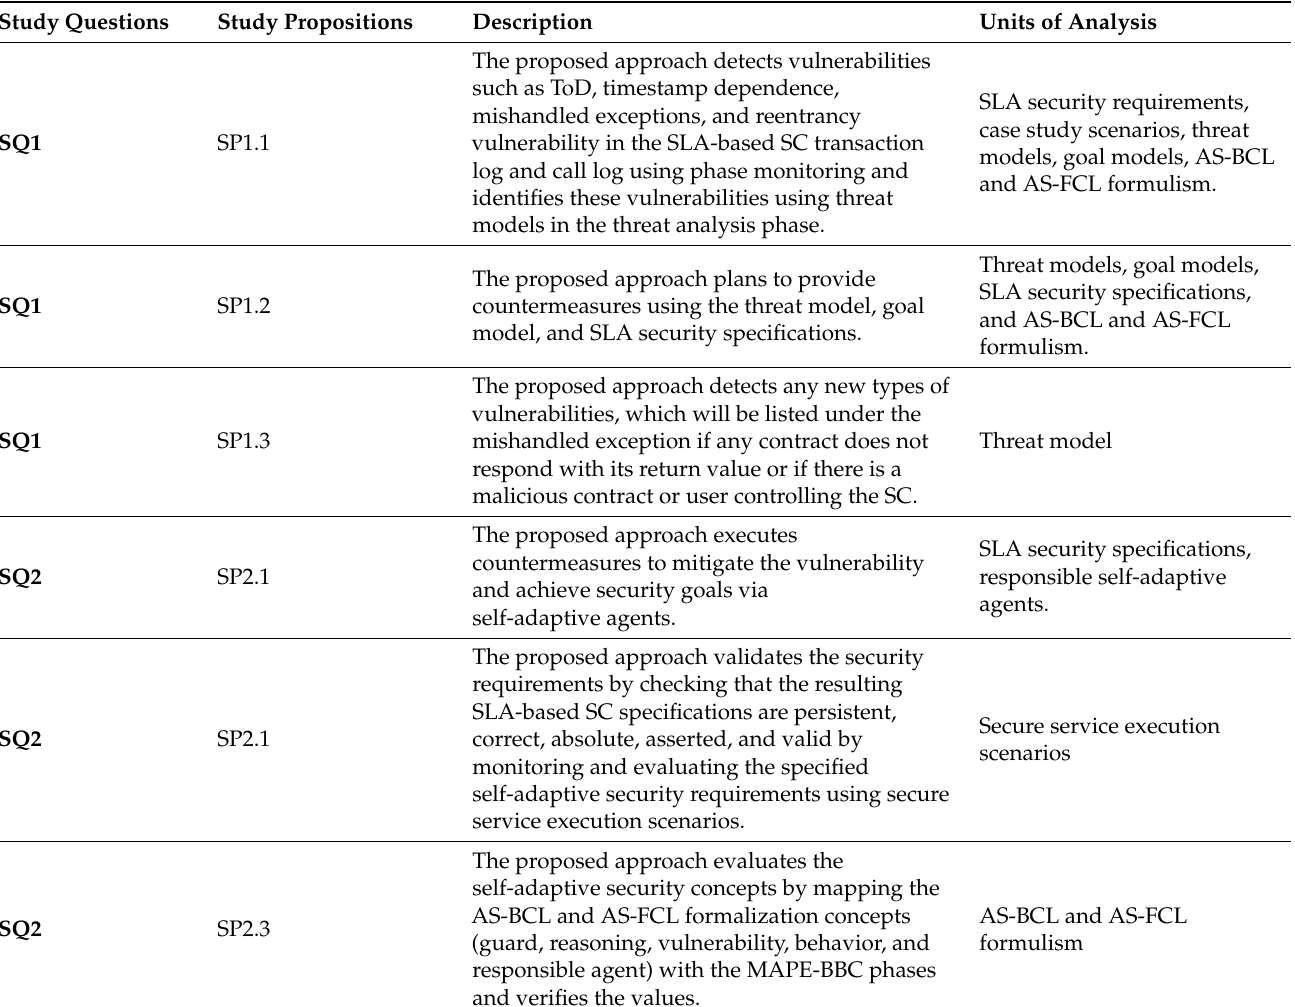
Table 1. Case study propositions and units of